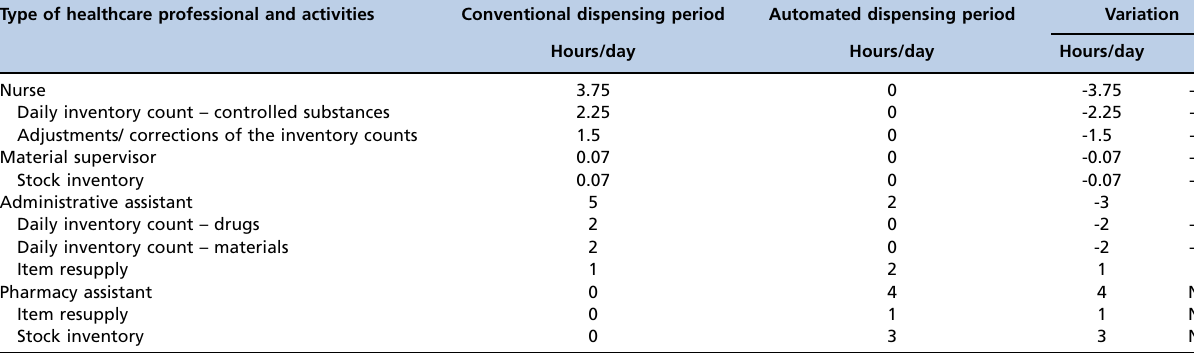
Table 4 - Activity and time associated with healthcare professional involvement in drug and material management in the Advanced Assistance Unit of the Hospital Sı´rio-Libaneˆs before and after implementing the automated medication dispensing system, according to the type of professional. 2013-2014. Sa˜o Paulo,